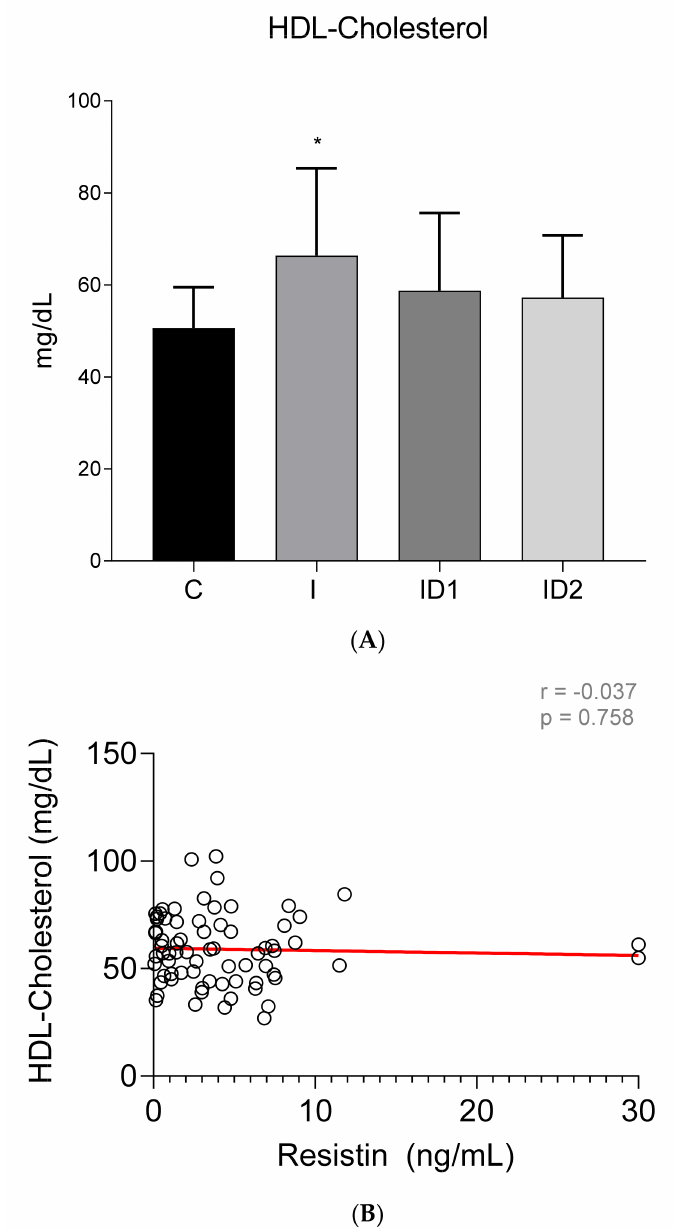
Figure 8. ( A ) Plasma HDL cholesterol concentration (mg/dL) in the different groups. Control group (C) n = 14, inflammatory group (I) n = 21, mild insulin dysregulation group (ID1) n = 18, severe insulin resistance group (ID2) n = 19. Bars represent mean + SD. Asterisks indicate significant differences with the control group (* p < 0.05). ( B ) Correlation between plasma HDL cholesterol concentration (mg/dL) and plasma resistin concentration (ng/mL) in 72 horses. The linear regression line is draw red solid (n = 72, r = 0.037, p =